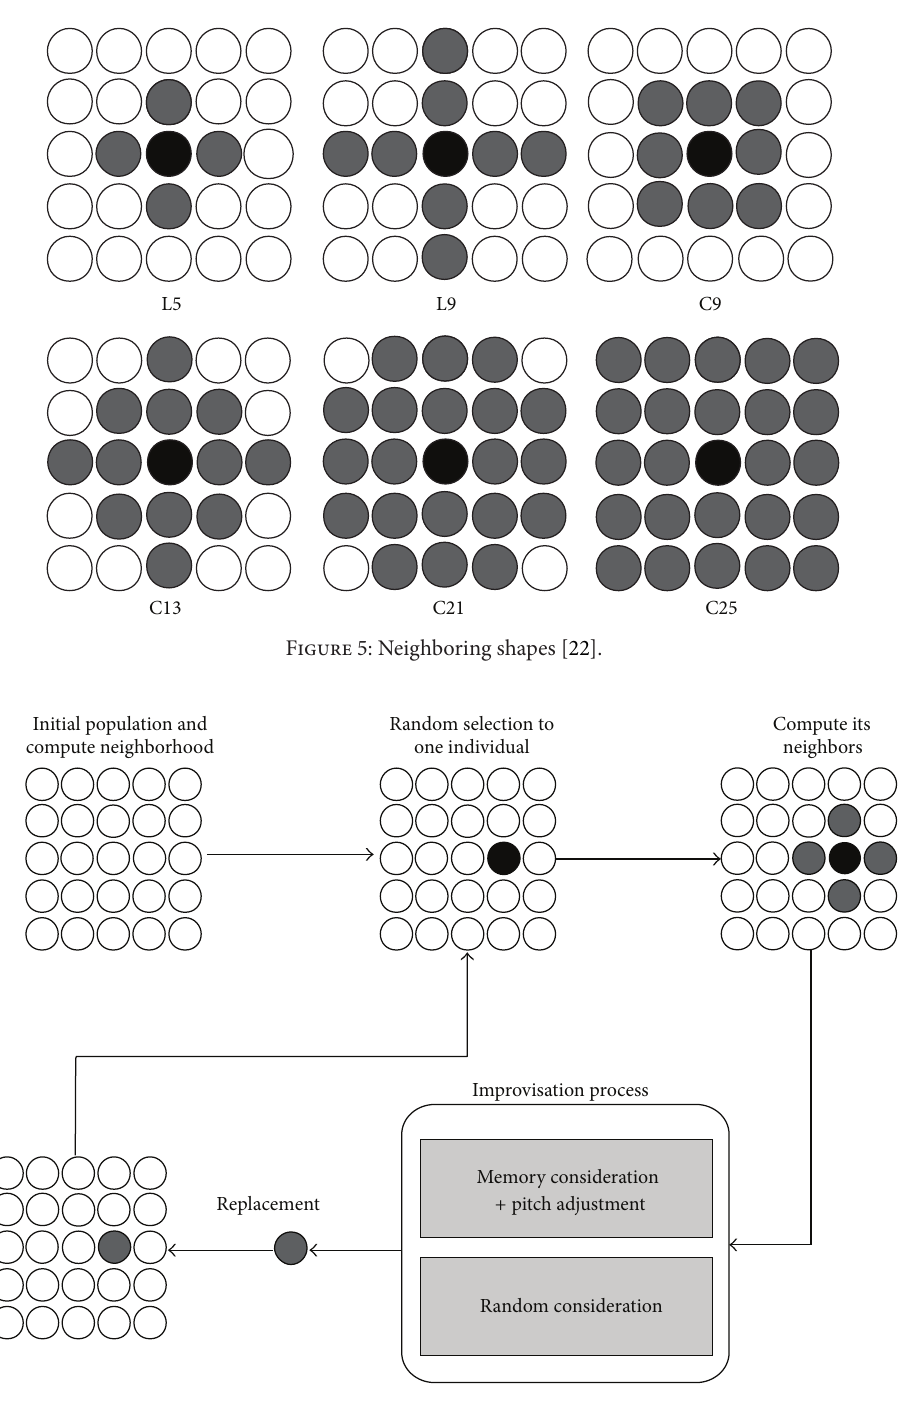
Figure 6: The processes fluency of cHS